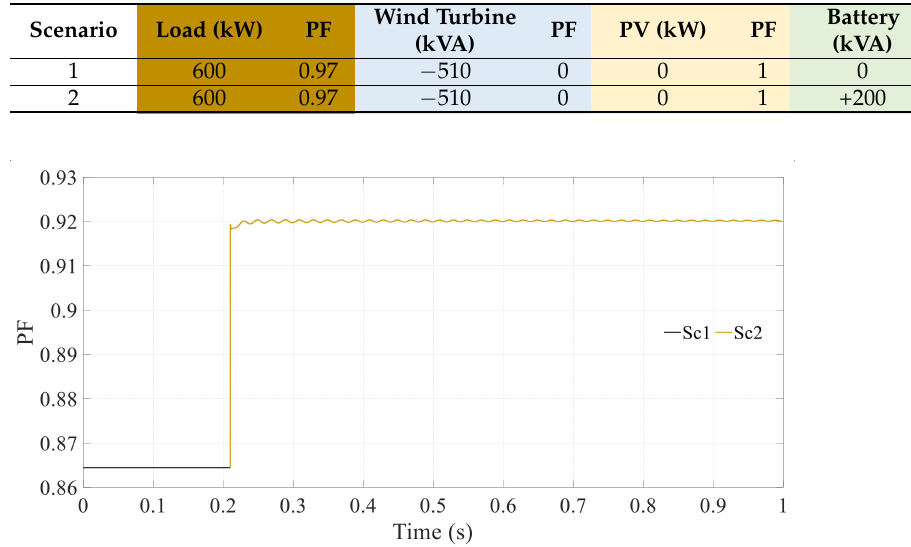
Figure 31. Improving the PF with reactive power control of the EV